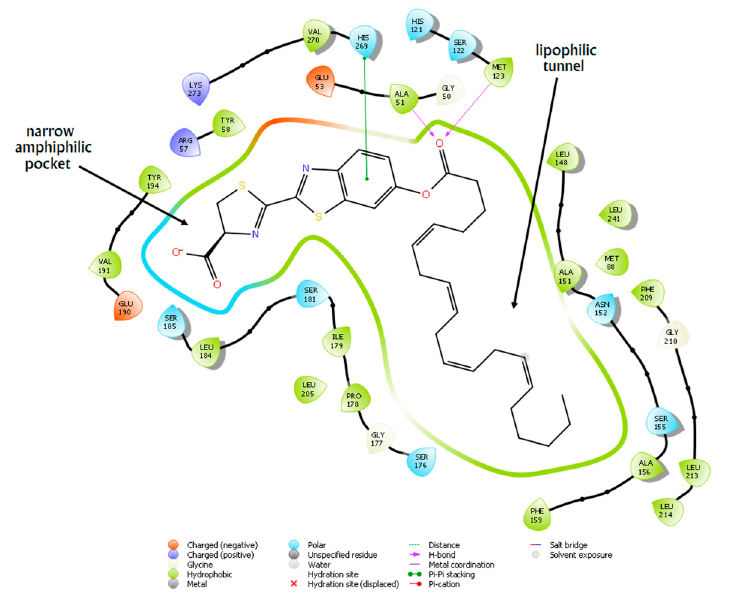
Figure 8. 2D representation of interactions between MAGL binding site and ArLuc- 1